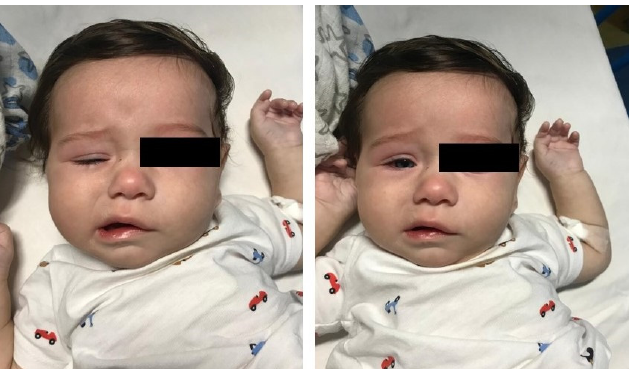
Figure 1. Right facial nerve palsy in the 4-month-old infant. These clinical features were observed at hospital admission (closed eyes on the left; open eyes on the right).